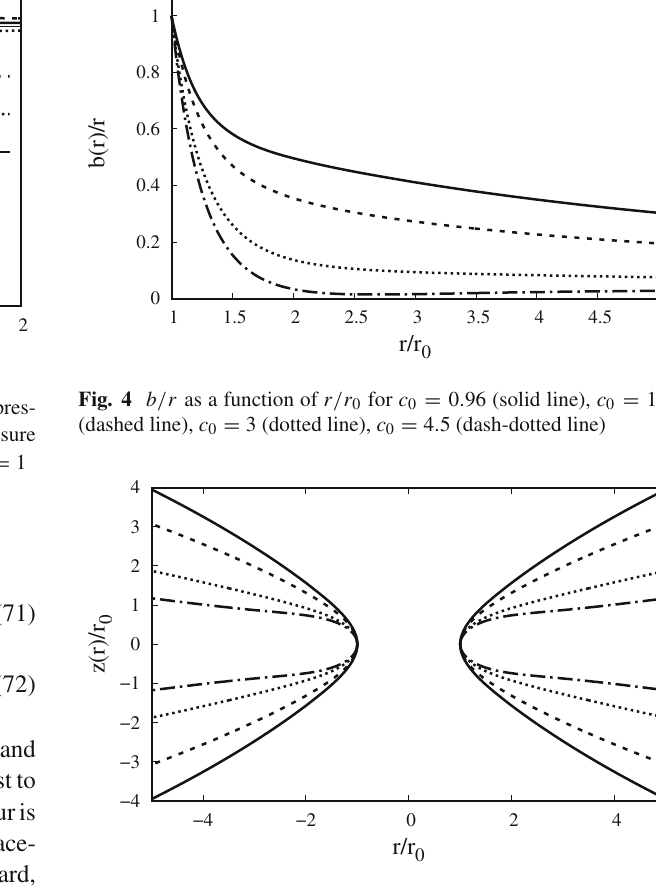
Fig. 5 Embedding diagram for c 0 = 0 . 96 (solid line), c 0 = 1 . 5 (dashed line), c 0 = 3 (dotted line), c 0 = 4 . 5 (dash-dotted